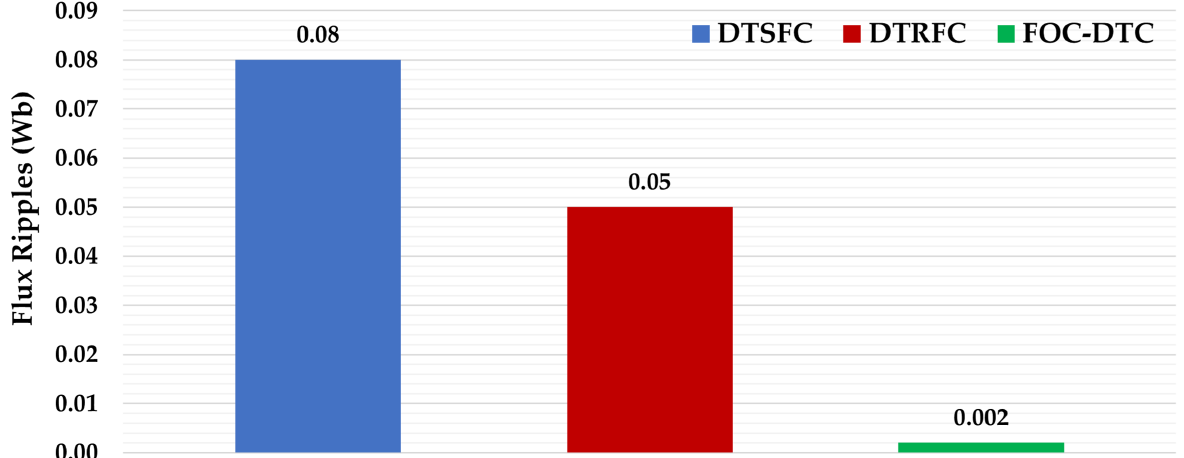
Figure 37. Comparisons of flux ripples for DTSFC, DTRFC, and the proposed